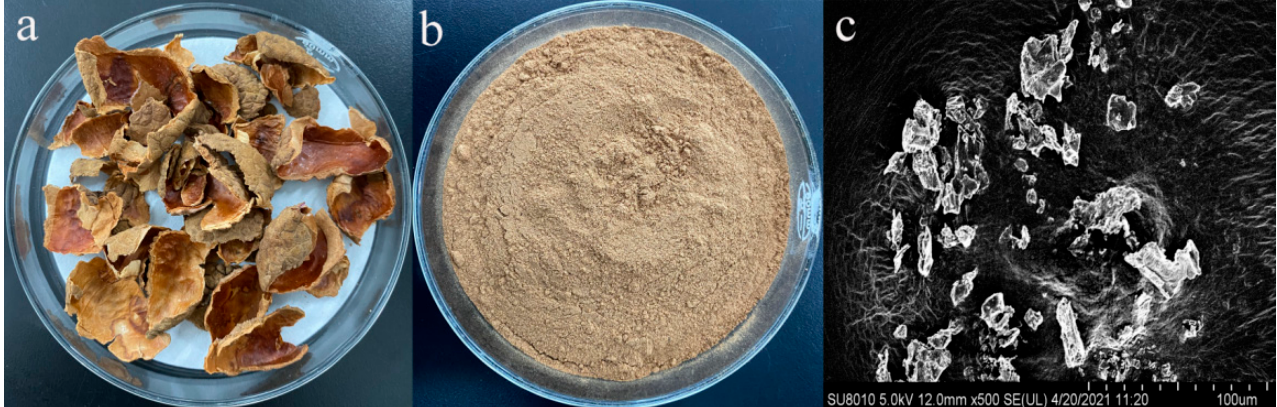
Figure 1. Freeze-dried lychee pericarp ( a ), LPP ( b ), and SEM image of LPP ( c